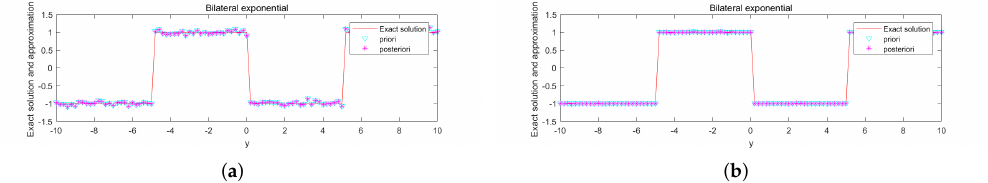
Figure 1. ( a ) δ = 1 × 10 − 1 . ( b ) δ = 1 × 10 − 2 . The exact solution and the regularized solution of a ( x ) when α = 1.4.